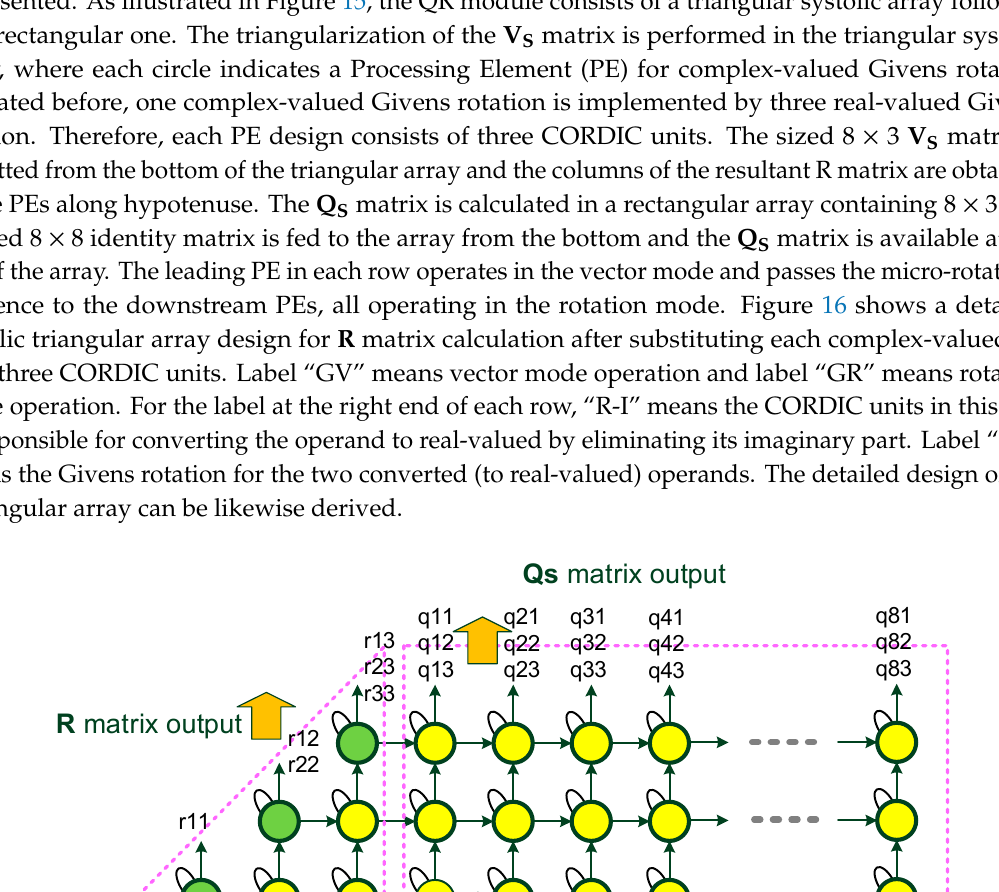
R-I M1 Figure 16. Systolic tri-array design for R matrix using real-valued Coordinate Rotation Digital Computer (CORDIC) units. The PM module performs a matrix multiplication to obtain the projection matrix. As shown in Figure 17, the design is a linear systolic array that consists of eight complex-valued MACs. The (cid:1791) (cid:1793) matrix is inputted to the module column by column in three consecutive clock cycles and a column of the P matrix is obtained every three clock cycles. For the Matching pursuit module, the projection of the codebook, i.e., (cid:2742) = (cid:1778) (cid:3009) ∙ (cid:1790) (cid:1793) is performed first. The codebook need to store 19 steering vectors and each vector is 8-dimensional with 24-bit complex-valued entries (12-bit for real part and 12-bit for imaginary part). The total memory size is only 456 bytes. Although we can use memory compiler to generate a small on-chip SRAM module for it, to support computing parallelism, these data are stored in registers so that they can be accessed in parallel. The projection is, again, a matrix-matrix multiplication and differs from the counterpart in the PM module only in matrix size. A similar linear systolic array design with eight MACs is adopted here. However, it takes 8 clock cycles to complete the projection of one steering vector from the codebook and there are 19 vectors in total. The norm 2 value of each projected vector is next calculated. Since this value is used in the magnitude comparison process, the square of the norm 2 value is calculated instead to eliminate square root operations. As